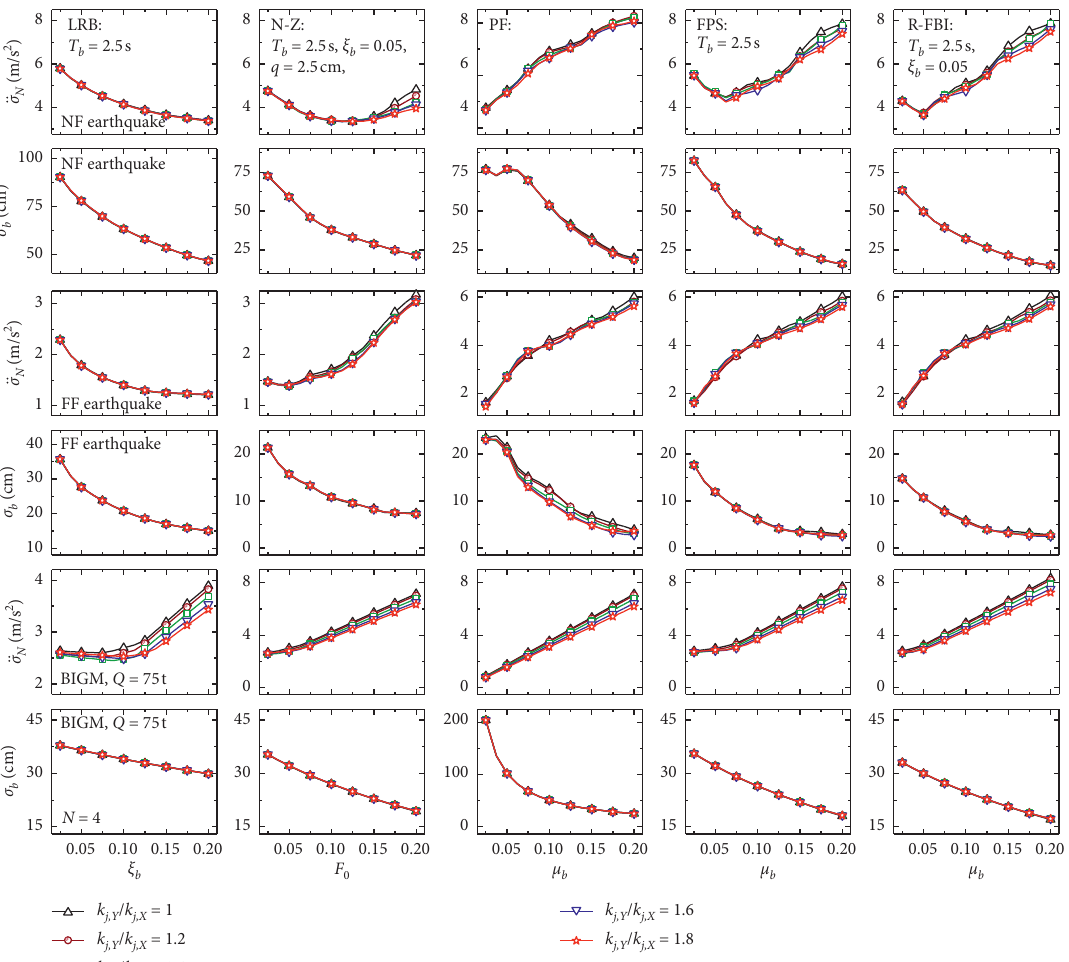
Figure 15: The effect of k k j,Y / j,X on the response of four-story base-isolated buildings under NF earthquake, FF earthquake, and